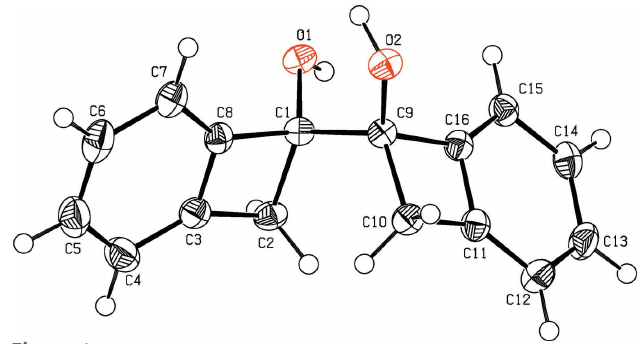
Figure 1 Perspective view of the title compound. Displacement ellipsoids are drawn at the 50% probability level.